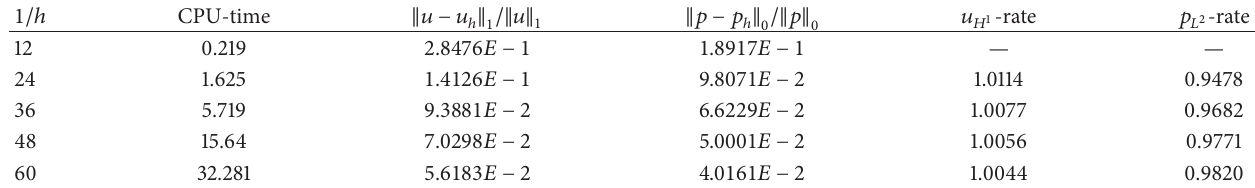
Table 6: Numerical results for the penalty method with ] = 1.0𝑒 − 4 , 𝛼 = 1.0𝑒 − 4 , and 𝑟 = 3